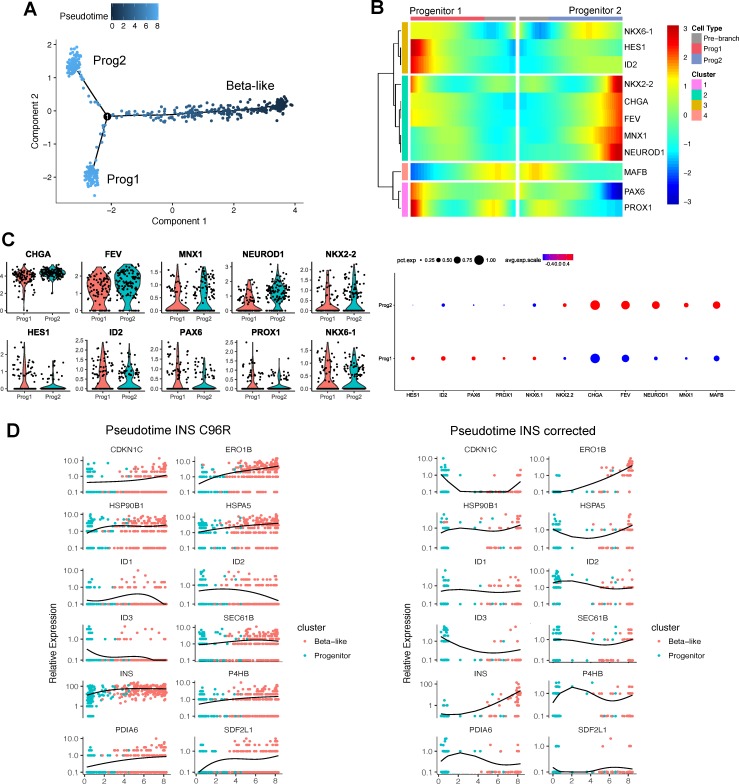
Pseudotime analysis of INS C96R vs INS corrected cells.(A) Pseudotime trajectory inferred from beta-like and progenitor clusters (non-reversed). (B) Heatmap clustering of selected marker genes differentially expressed genes between the two progenitor branches. (C) Violin plots representing the expression of selected markers genes in the two progenitor populations. Dot plots represent the percentage of cells in a given progenitor population expressing a particular marker, and the scaled mean relative expression of the gene. (D) Relative expression of the genes differentially regulated along pseudotime between INS C96R and INS corrected cells, presented as a heatmap in Figure 2F. Graphs represent individual single cell expression levels and the expression trend fitted over pseudotime.